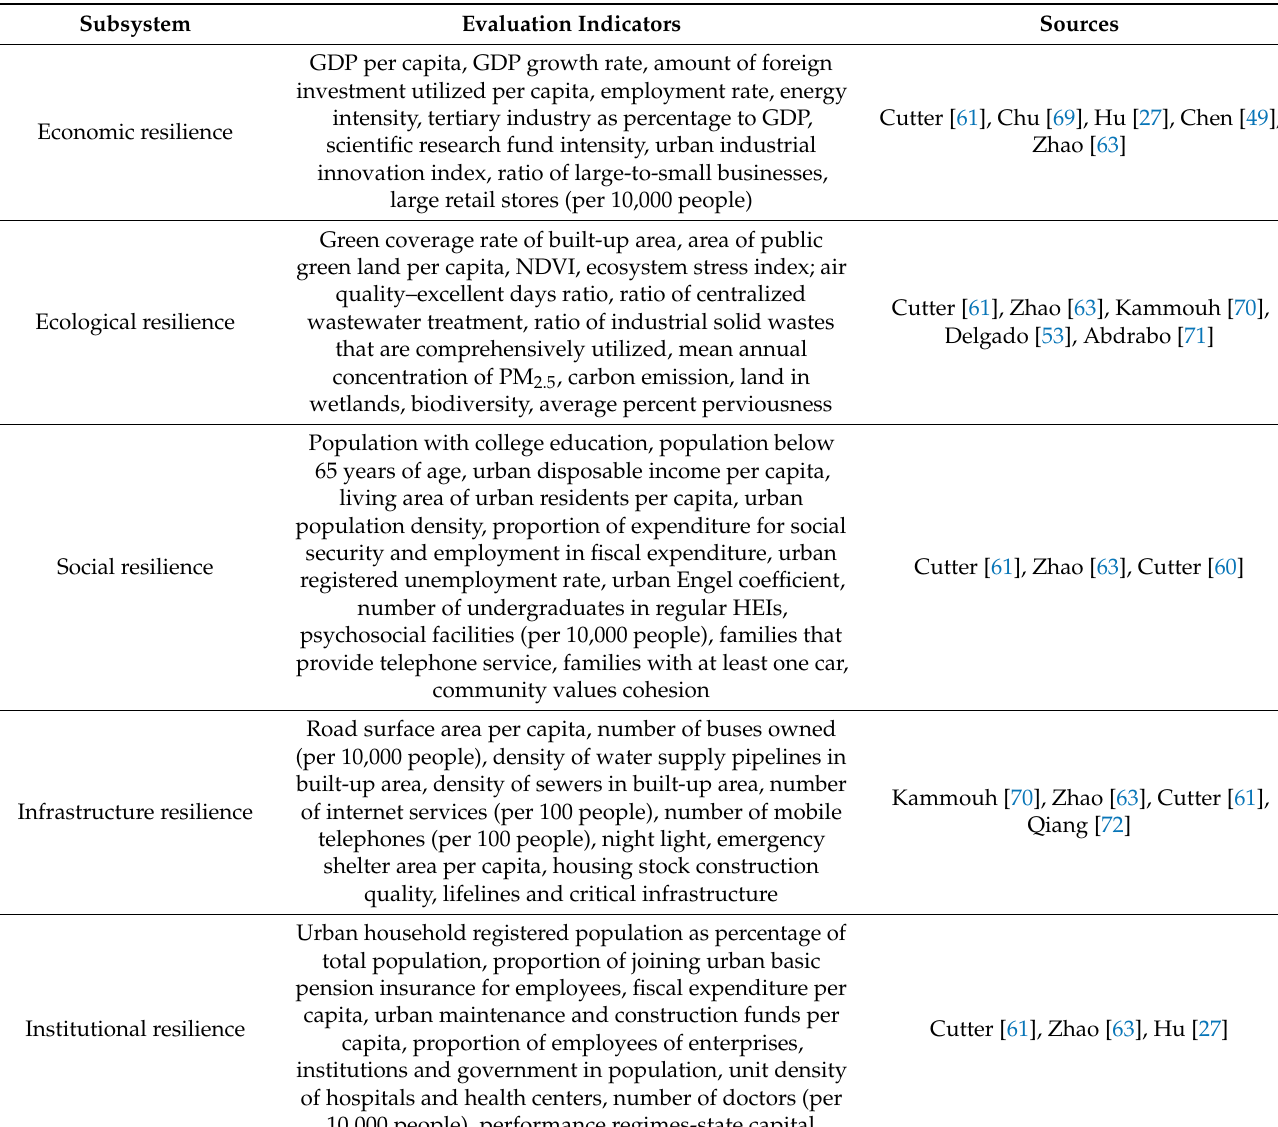
Table 2. Previous study of evaluation index system for urban